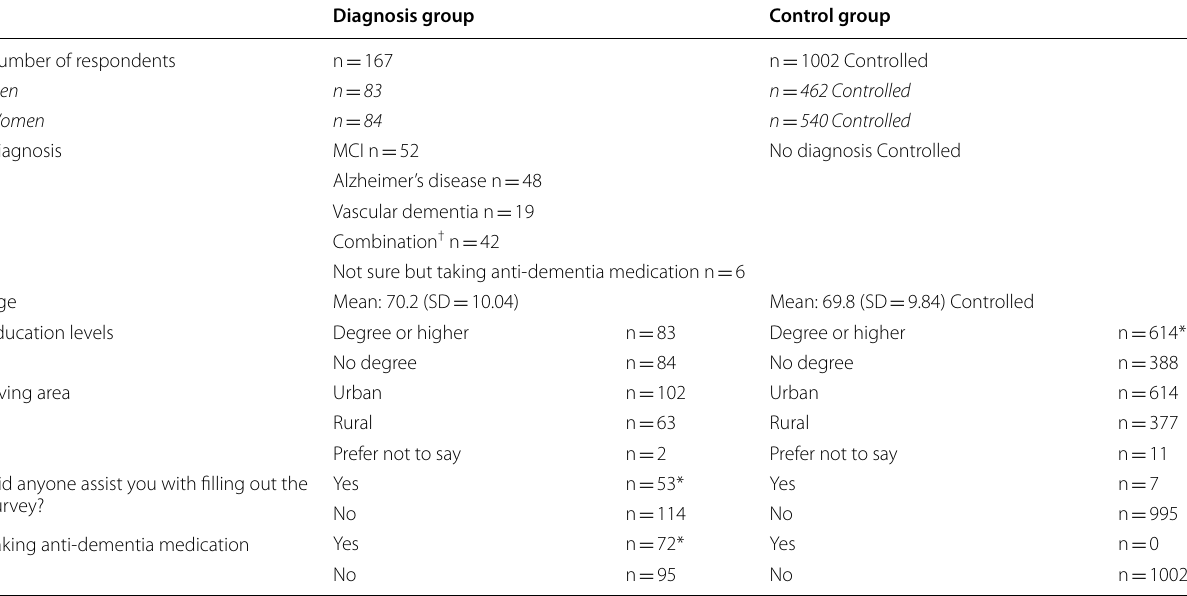
Values which are statistically more likely are marked with * † MCI and Other (n 7); Frontotemporal dementia (n 7); Mixed dementia (n 4); Alzheimer’s disease and Vascular Dementia (n 3); MCI and Alzheimer’s disease = = = = (n 2); Subjective cognitive disorder (n 2); Parkinson’s disease (n 2); Dementia with Lewy bodies (n 2); Alzheimer’s disease, Mixed dementia, Vascular dementia = = = = (n 1); MCI and Mixed dementia (n 1); Alzheimer’s disease, Mixed dementia (n 1); Mixed dementia, Vascular dementia (n 1); MCI and Vascular dementia (n = = = = Alzheimer’s disease, Vascular dementia, Not sure (n 1); Mixed dementia, Frontotemporal dementia (n 1); Frontotemporal dementia, Korsakoff syndrome (n = = Parkinson’s disease dementia (n 1); Parkinson’s disease dementia, Parkinson’s disease (n 1); Korsakoff syndrome (n 1); Vascular dementia, Parkinson’s disease = = =